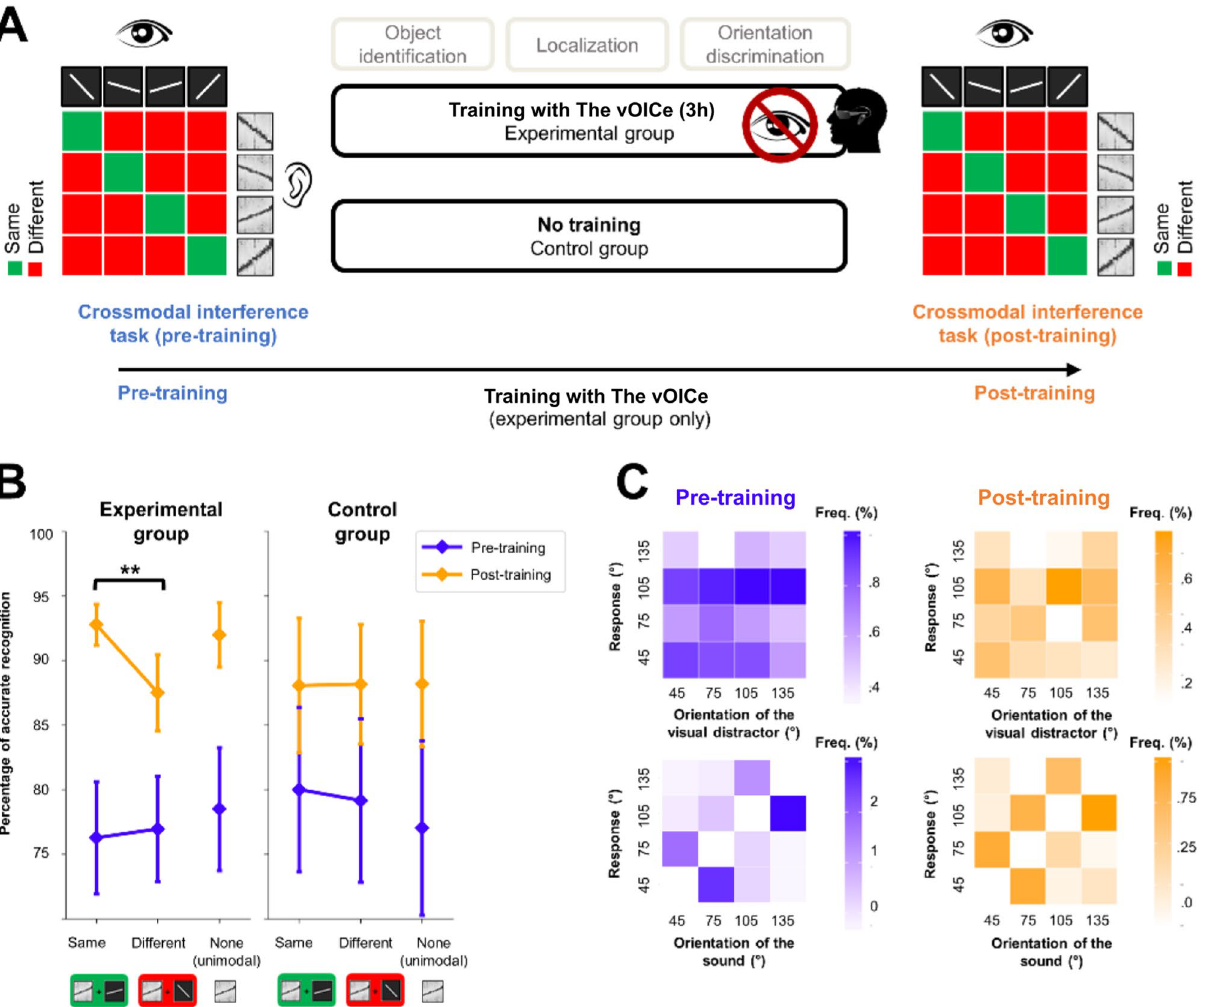
Figure 2. Effect of training with the vOICe on the crossmodal interference task. ( A ) Description of the three phases of the experimental protocol. For the experimental group, the crossmodal interference task was performed before (pre-training) and after (post-training) training with the vOICe. For the control group, the crossmodal interference task was performed twice, without training with the vOICe in between. ( B ) Mean accuracy (percentage of correct recognition) in the crossmodal interference task across participants of the experimental and control groups, as a function of the Session (pre-training, post-training) and the Type of visual distractor (same, different, none). Error bars represent standard error of the mean. ** p < 0.01. ( C ) Analyses of the distribution of erratic responses made in the crossmodal interference task by the participants involved in the experimental group during the pre-training (in blue) and post-training (in orange) sessions. In the top row, the erratic responses are classified as a function of the orientation of the visual distractor. In the bottom row, the erratic responses are classified as a function of the orientation of the auditory converted lines (bimodal block, see Fig. 1B). The auditory target and the visual distractor had either the same orientation, or a different one (see Fig. 1C). These visual lines are irrelevant to performing the task. There was also a unimodal block in which the auditory targets were presented alone, i.e. without visual distractors. The auditory targets were generated using the applet The vOICe. They corresponded to differently-oriented white lines on a black background. Four orientations were presented: 45°, 75°, 105°, and 135° relative to the vertical, with a clockwise rotation. The sounds were presented at an intensity of 65 dBA. The visual distractor consisted of oriented white lines on a black background. They were 10° visual angle long, 0.5° thick, and had a contrast of 0.42. The same four orientations as those of the auditory targets were used. Each trial began with the simultaneous presentation of both a visual and an auditory mask, lasting 1500 ms. Then, a fixation cross was presented at the centre of the screen for 1000 ms, followed by the 1000 ms auditory target and the visual distractor. Trials were separated by a 2000-ms inter-stimulus interval. The participants were asked to press one key, out of four, that corresponded to the sound they heard. The four adjacent keys (F, G, H, and J) on the computer keyboard were used. The participants were instructed to respond with their dominant